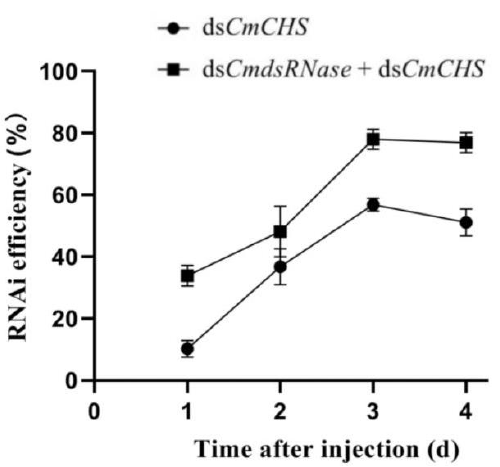
Figure 8. Expression levels of CmCHS at different times after dsRNA injection. The CmCHS expression levels in the third-instar C. medinalis larvae were detected with ddPCR four days after injection of ds CmCHS or the mixture of ds CmdsRNase and ds CmCHS . Larvae injected with ds GFP were used as the control group. Each bar represents the mean ± SD. One asterisk above bars indicates a significant difference at p < 0.05 and two asterisks indicate a very significant difference at p < 0.01 according to Duncan’s test.